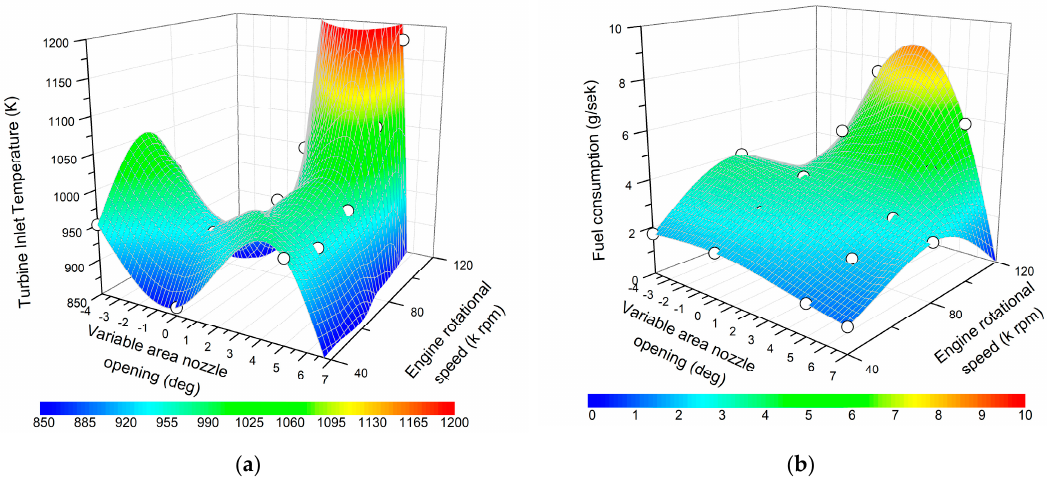
Figure 7. Turbine variable area nozzle impact on: ( a ) turbine inlet temperature; ( b ) fuel consumption.